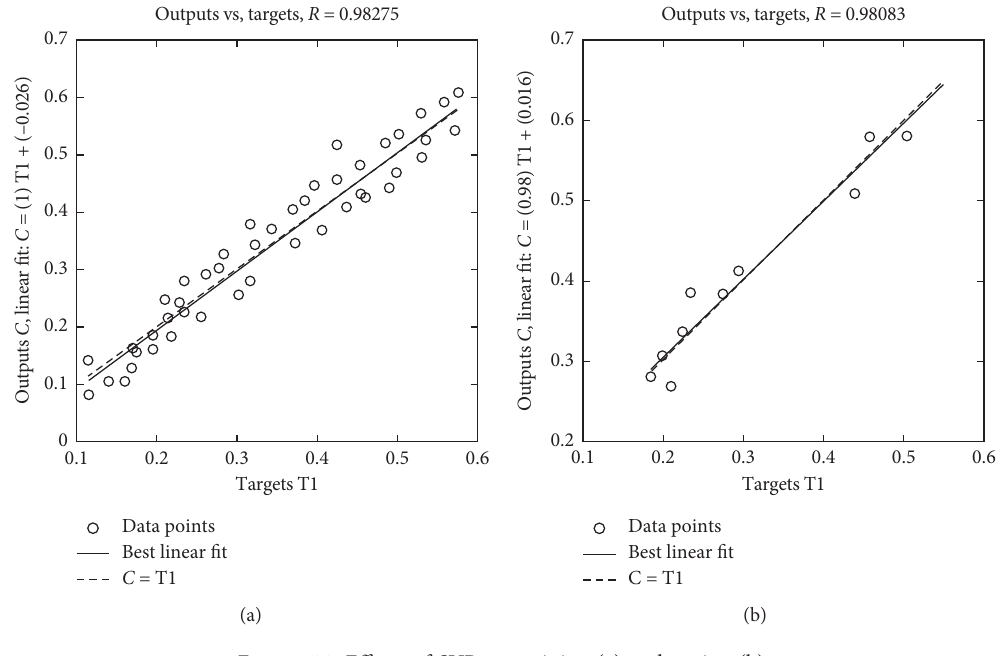
Figure 11: Effects of SVR on training (a) and testing